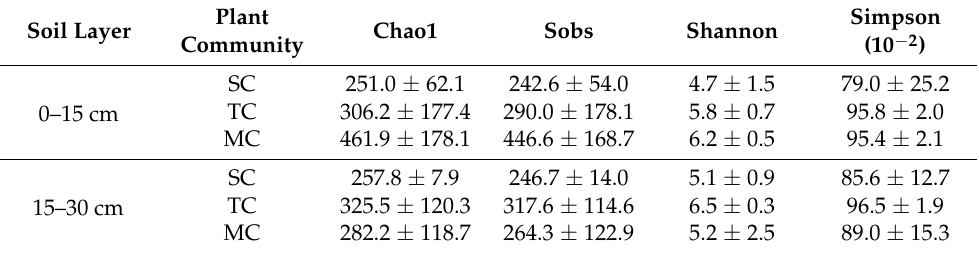
Table 2. The soil fungal diversity indices (Chao1, Sobs, Shannon, Simpson) in different communities (there was no significant difference of each diversity index among the three plant communities in the same soil layer at a p > 0.05 according to Tukey’s test).